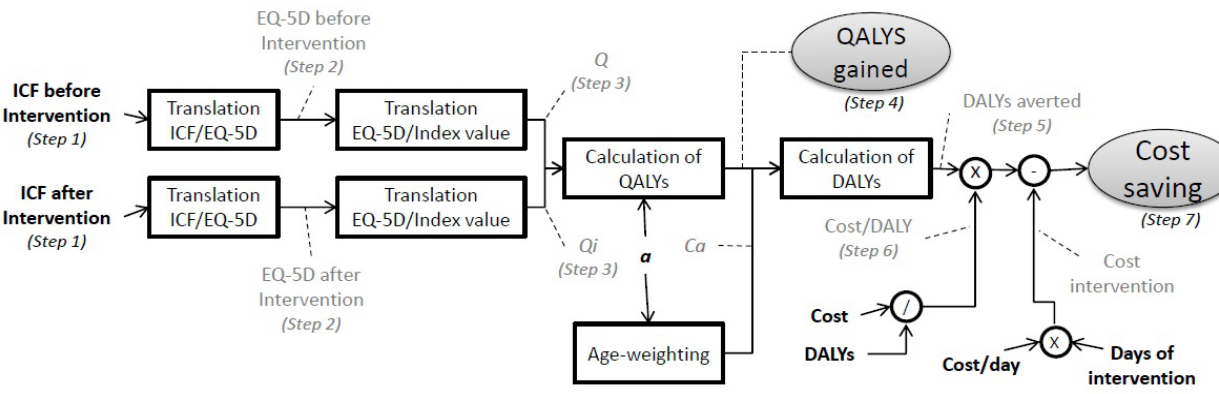
Figure 2. Block diagram of the methodology